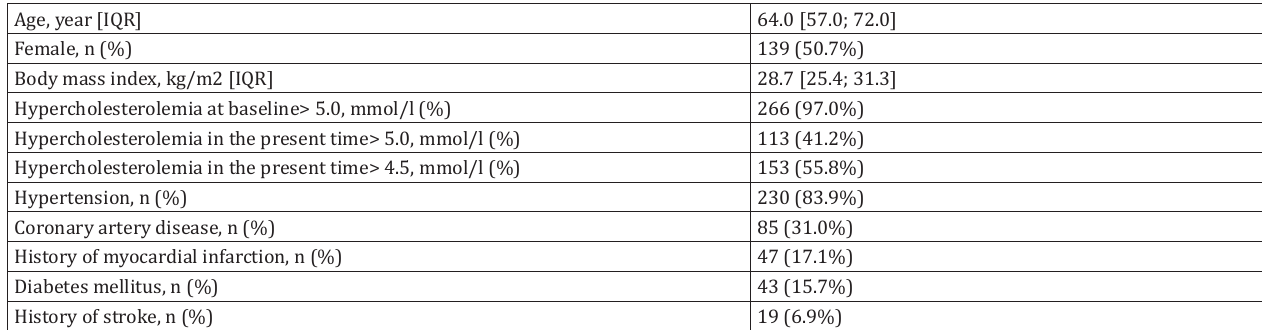
Baseline characteristics of study group